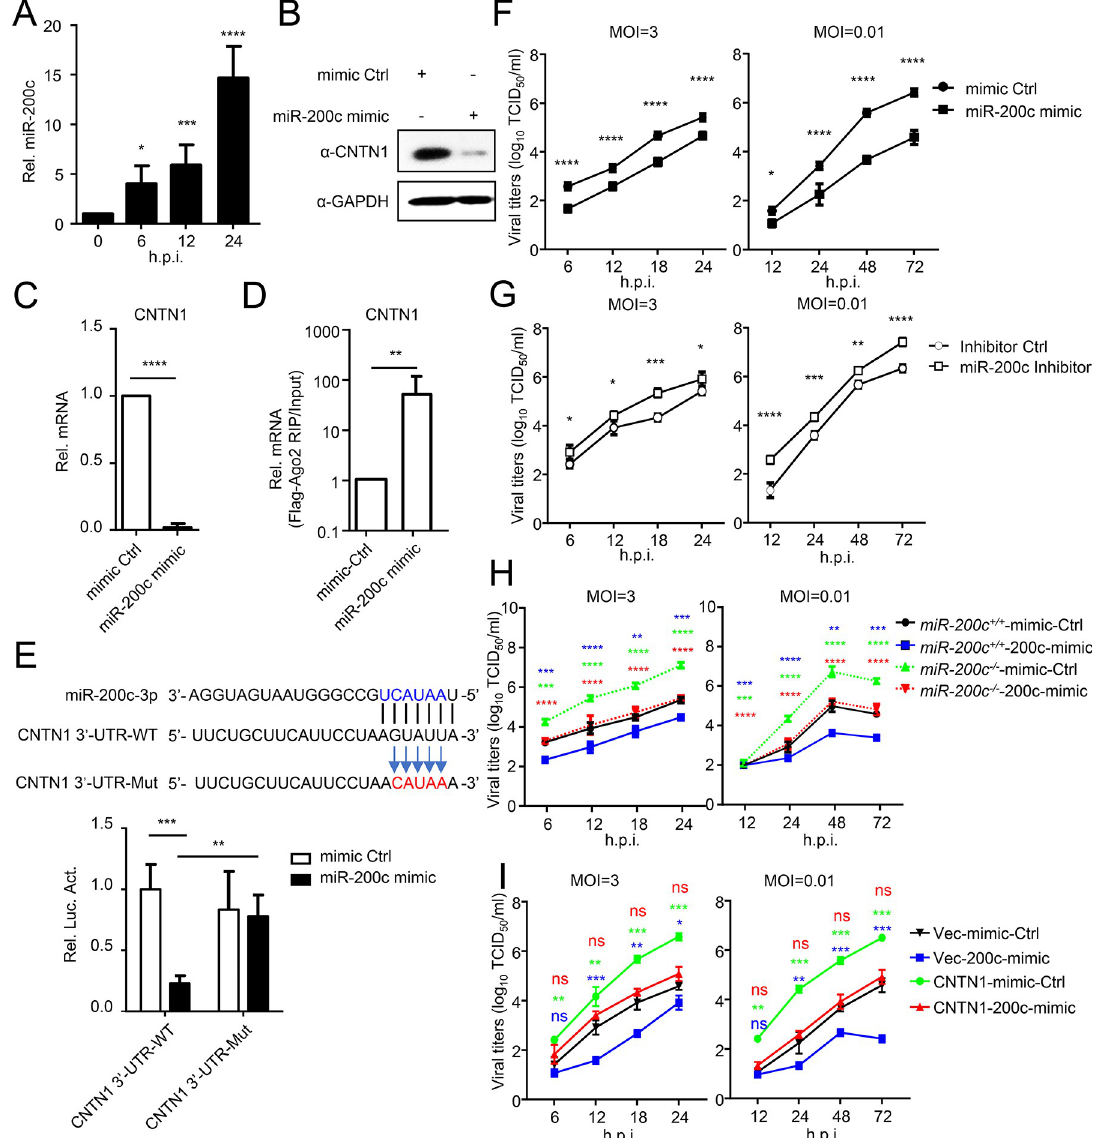
Fig 2. CNTN1 expression is downregulated by virus-induced miR-200c. (A) The expression of miR-200c in A549 cells infected with H5N6 virus for indicated times was quantified by using qPCR analysis. (B-C) HEK293 cells were transfected with miR-200c mimic or mimic control for 24 h before immunoblotting and qPCR analysis. (D) A549 cells were transfected with Flag-Ago2 in the presence of either the miR-200c mimic or mimic control. Twenty-four hours later, the cells were subjected to RIP assay with an anti-Flag antibody. The level of CNTN1 mRNA was quantified by using a qPCR assay. (E) Predicted miR-200c binding sites in the 3’-UTR of the CNTN1 mRNA. Perfect matches in seed regions are indicated by lines. Mutations (indicated by arrows) were generated in the binding sites of the 3’-UTR for the reporter gene assay. HEK293 cells were transfected with the wild-type or mutant of the CNTN1 3’-UTR reporter plasmid and the miR-200c mimic or mimic control for 24 h prior to the luciferase assays. (F) A549 cells were transfected with the miR-200c mimic or mimic control, followed by infection with H5N6 virus at an MOI of 0.01 or 3. At the indicated times post-infection, the supernatant containing viral particles was assessed in the TCID 50 assay. (G) A549 cells were transfected with the miR-200c inhibitor or inhibitor control, followed by infection with H5N6 virus at an MOI of 0.01 or 3. At the indicated times post-infection, the supernatant containing viral particles was assessed in the TCID 50 assay. (H) miR-200c +/+ or miR-200c -/- cells were transfected with the miR-200c mimic or mimic control. Twenty-four hours later, the cells were infected with H5N6 virus at an MOI of 0.01 or 3. At the indicated times post-infection, the supernatant containing viral particles was assessed in the TCID 50 assay. The data collected from miR-200c -/- cells are shown as dotted lines. The significant difference between miR-200c +/+ -mimic-Ctrl and miR-200c +/+ -200c-mimic is labeled in blue; the significant difference between miR-200c +/+ -mimic-Ctrl and miR-200c -/- -mimic-Ctrl is labeled in green; the significant difference between miR-200c -/- -mimic-Ctrl and miR-200c -/- -200c-mimic is labeled in red. (I) A549 cells were transfected with the miR-200c mimic or mimic control, and the CNTN1 expression plasmid or Vec. Twenty-four hours later, the cells were infected with H5N6 virus at